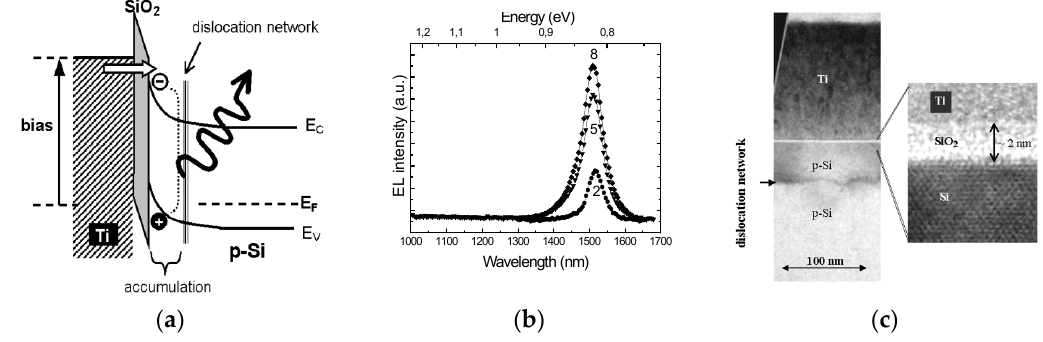
Figure 24. ( a ) Schematic band diagram of a MOS-LED with thin tunneling oxide and a dislocation network close to the Si/oxide interface. ( b ) Electroluminescence spectra at 80 K of the MOS-LED with 1.5 μ m radiation caused by the network. The intensity is found to increase sub-linearly with increasing tunneling current measured at 2, 5 and 8 mA, respectively. ( c ) TEM cross-section of the MOS-LED consisting of a 134 nm Ti layer on 1.8 nm Si oxide. The network is positioned in ~45 nm depth.